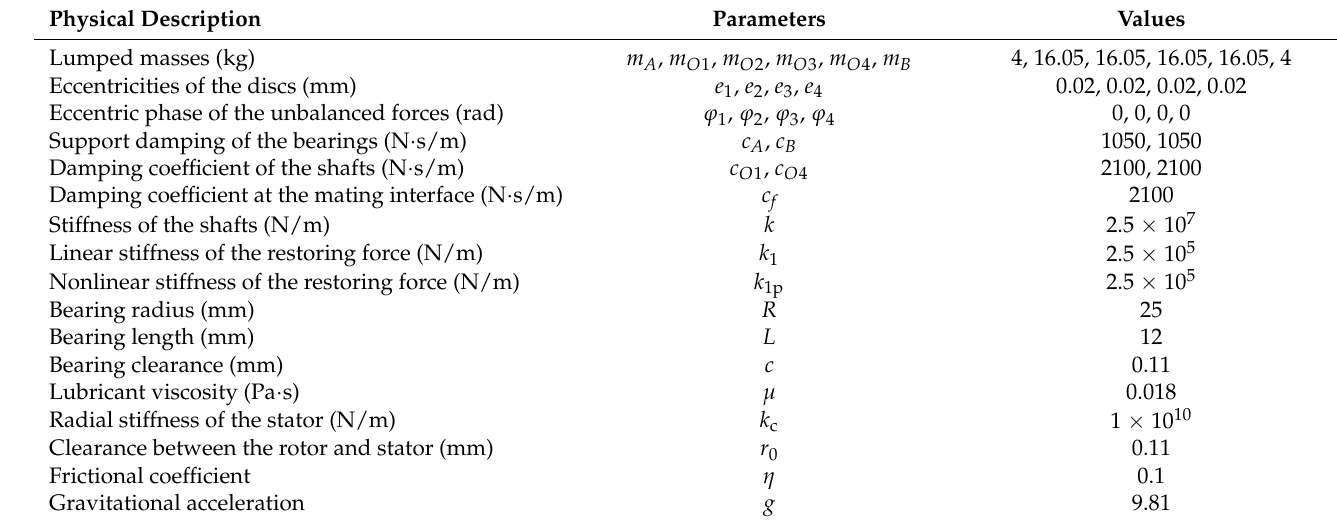
Table 2. Structure parameters of the multi-disc bolted joint rotor-bearing system for numerical